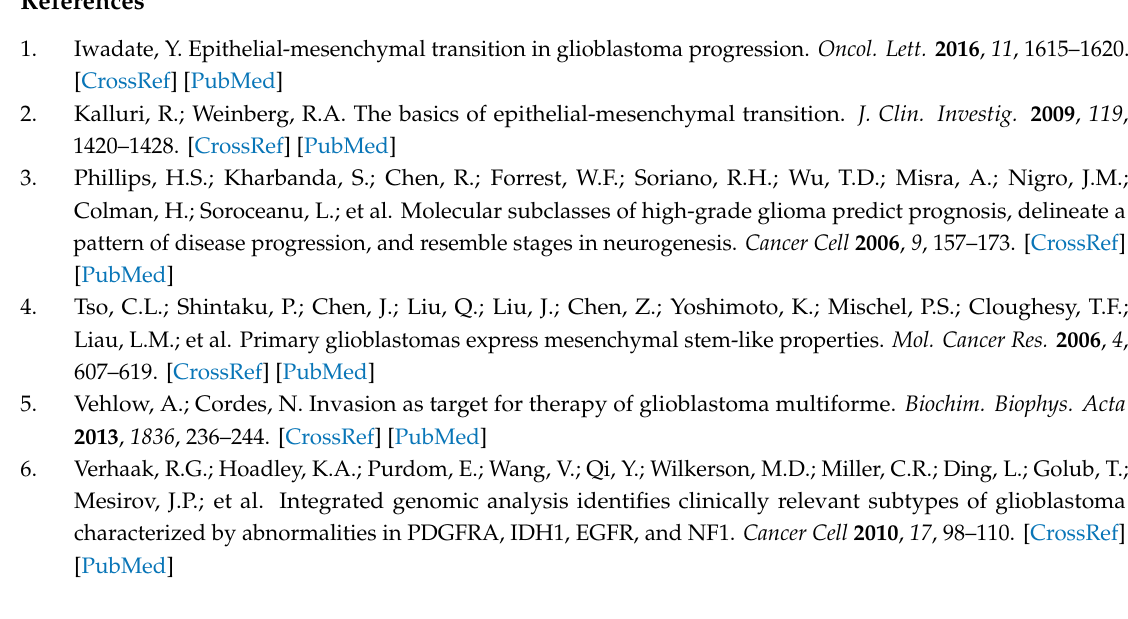
Figure S1. Identification of TW S68 phosphorylation by mass spectrometry; Figure S2. Quantification of relative fraction of phosphorylated TW in U87dTW-A and GBM8 cells with TW overexpression; Figure S3. TE:E12 dimer over-expression in G131 primary glioma cells promotes invasive phenotype; Figure S4. Invasion of T98G cells with overexpression of empty vector, WT TW:E12 and TW(S68A):E12